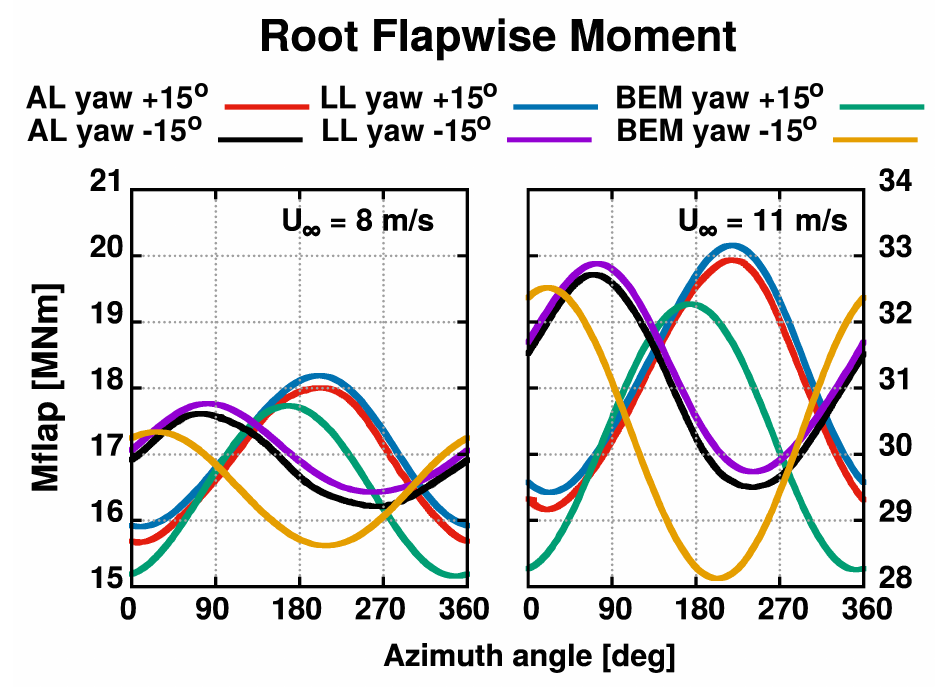
Figure 23. Out-of-plane bending moment of blade root at 15 ◦ yawed wind speed at 8 and 11 m/s.